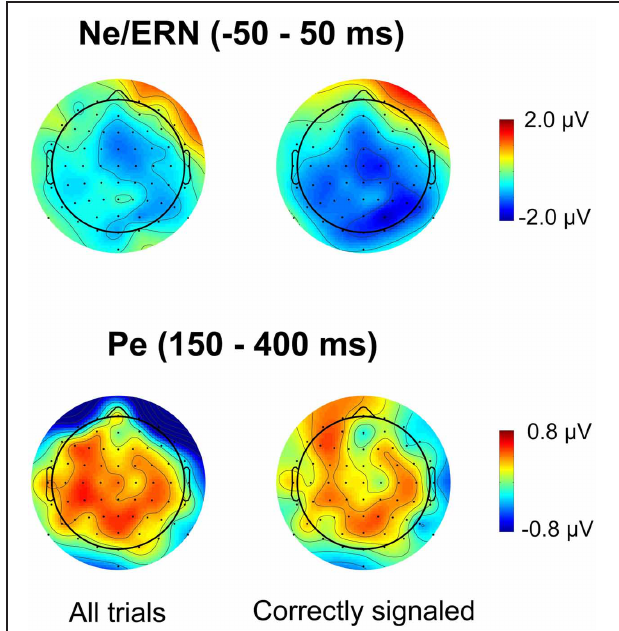
FIGURE 3 | Spatial distribution of ERPs for the difference between errors in the lowSP condition and errors in the highSP condition. Upper row: Time period of the Ne/ERN ( − 50 – 50ms). Lower row: Time period of the Pe (150–400 ms). Left column: Data from all errors. Right column: Data from signaled errors. HighSP = high speed pressure. LowSP = low speed pressure.